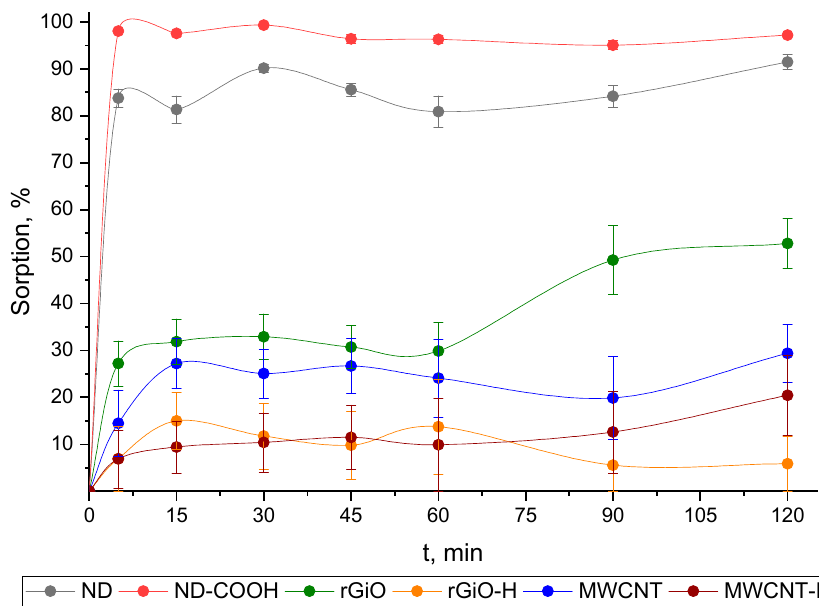
Figure 1. Sorption kinetics of 68 Ga by studied CNMs from an aqueous solution with a pH 7 at m / V ratio of 100 µ g / mL and 25 ◦ C.